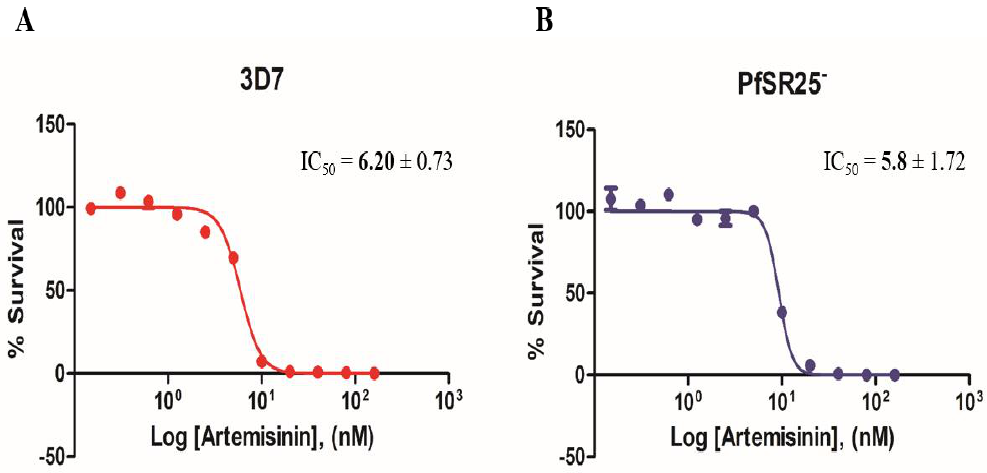
Figure 3. Dose-response curves for Artemisinin in P. falciparum . Cultures of P. falciparum 3D7 ( A ) and PfSR25 - ( B ) were incubated with artemisinin (0.15 nM to 160 nM) for 72 h. The final parasitemia was obtained using flow cytometry using double labeling with SYBR Green I and MitoTracker Deep Red.